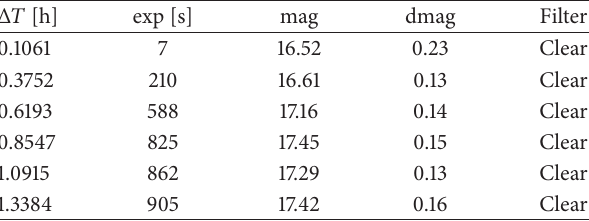
Table 7: GRB 080330: observing log of BOOTES-1B.